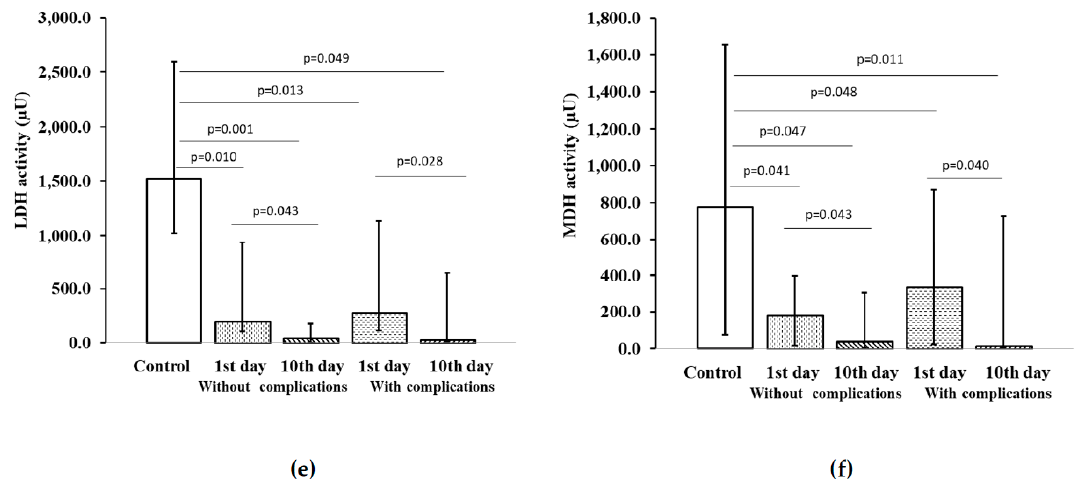
Figure 4. Activity of NAD-dependent platelet dehydrogenases in patients with ACS and ADD, depending on the development of complications: ( a ) NAD–GluDH activity; ( b ) NADH–MDH activity; ( c ) NADH–GluDH activity; ( d ) Gly3PDH activity; ( e ) LDH activity; ( f ) MDH activity. Notes: Values expressed as median and interquartile range in the form of 25 and 75 percentiles, p < 0.05 was considered statistically significant. Wilcoxon matched-pairs test for patients without complications on the 1st vs. 10th day of the examination and for patients with complications on the 1st vs. 10th day of the examination. Mann–Whitney U test for patients vs. control subjects and for patients with complications vs. patients without complications. Notes: µ U—microunit.